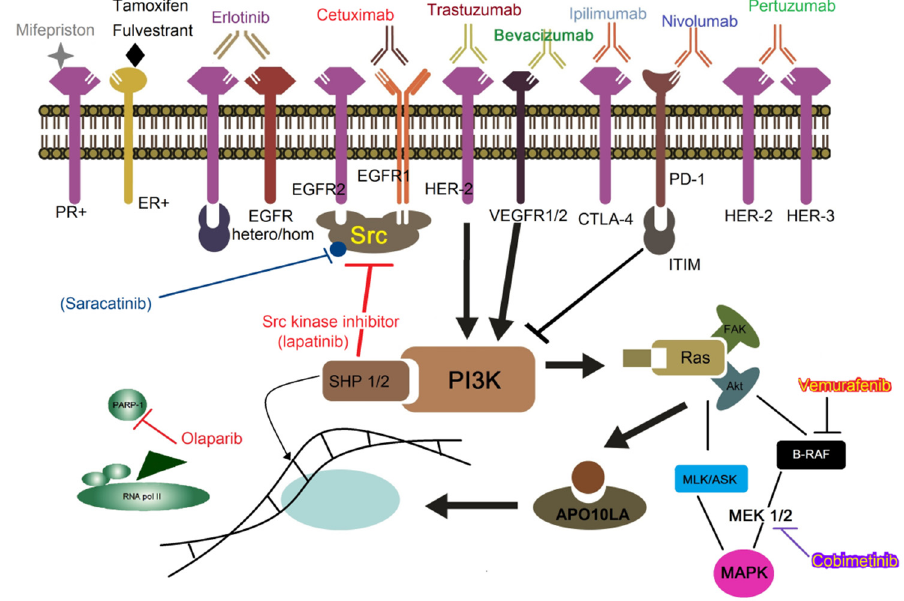
Figure 1. Therapeutic monoclonal antibodies and inhibitors approved for use in oncology.